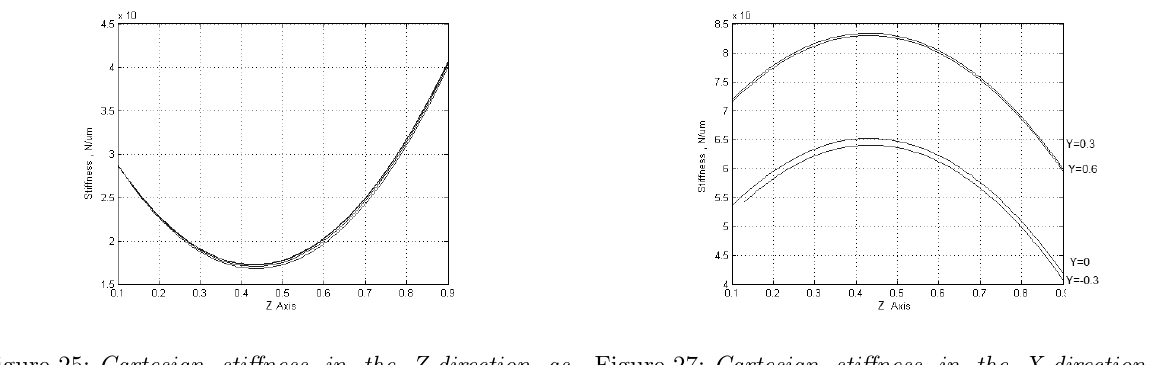
Figure 27: Cartesian stiffness in the X-direction as function of the Z-coordinate at fixed